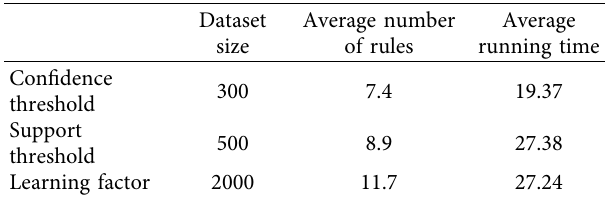
Figure 5: Related parameters of experimental materials. Table 3: Run